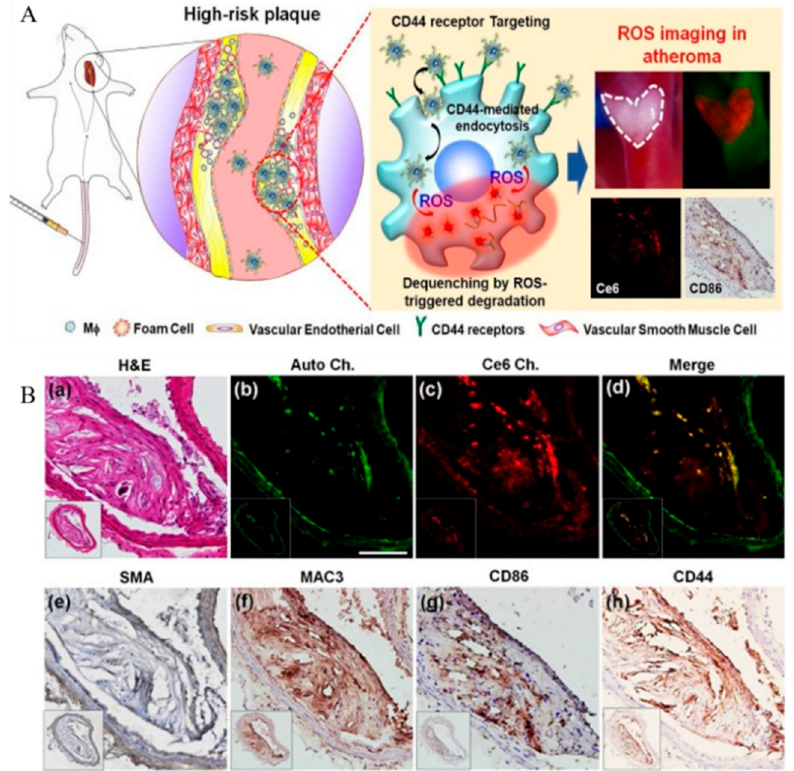
Figure 5. ( A ) Schematic of ROS imaging of proinflammatory macrophages within atherosclerotic plaques. ( B ) Histological and immunohistochemical evaluations. ( a ) H&E staining. ( b ) Autofluores- cence signals from elastin (green), ( c ) NIRF signals (red), and ( d ) merged image. Immunohistochemi- cal staining of ( e ) SMA, ( f ) MAC3, ( g ) CD86, and ( h ) CD44. Scale bar: 25 mm. Adapted from